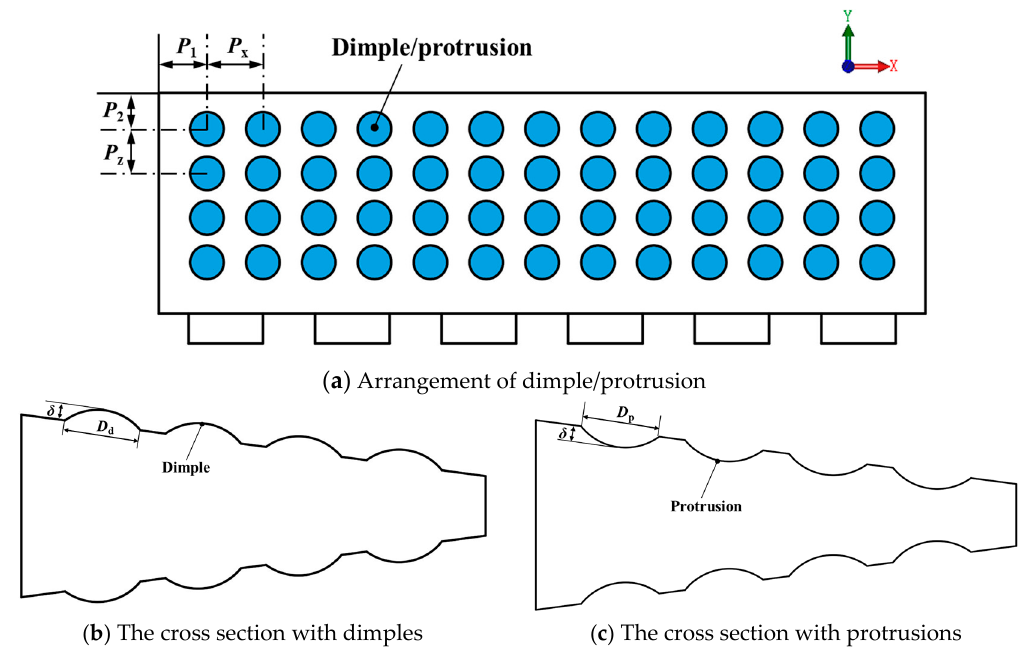
Figure 3. Dimple/protrusion structure and arrangement in the trailing edge channels. Figure 3. Dimple / protrusion structure and arrangement in the trailing edge channels.